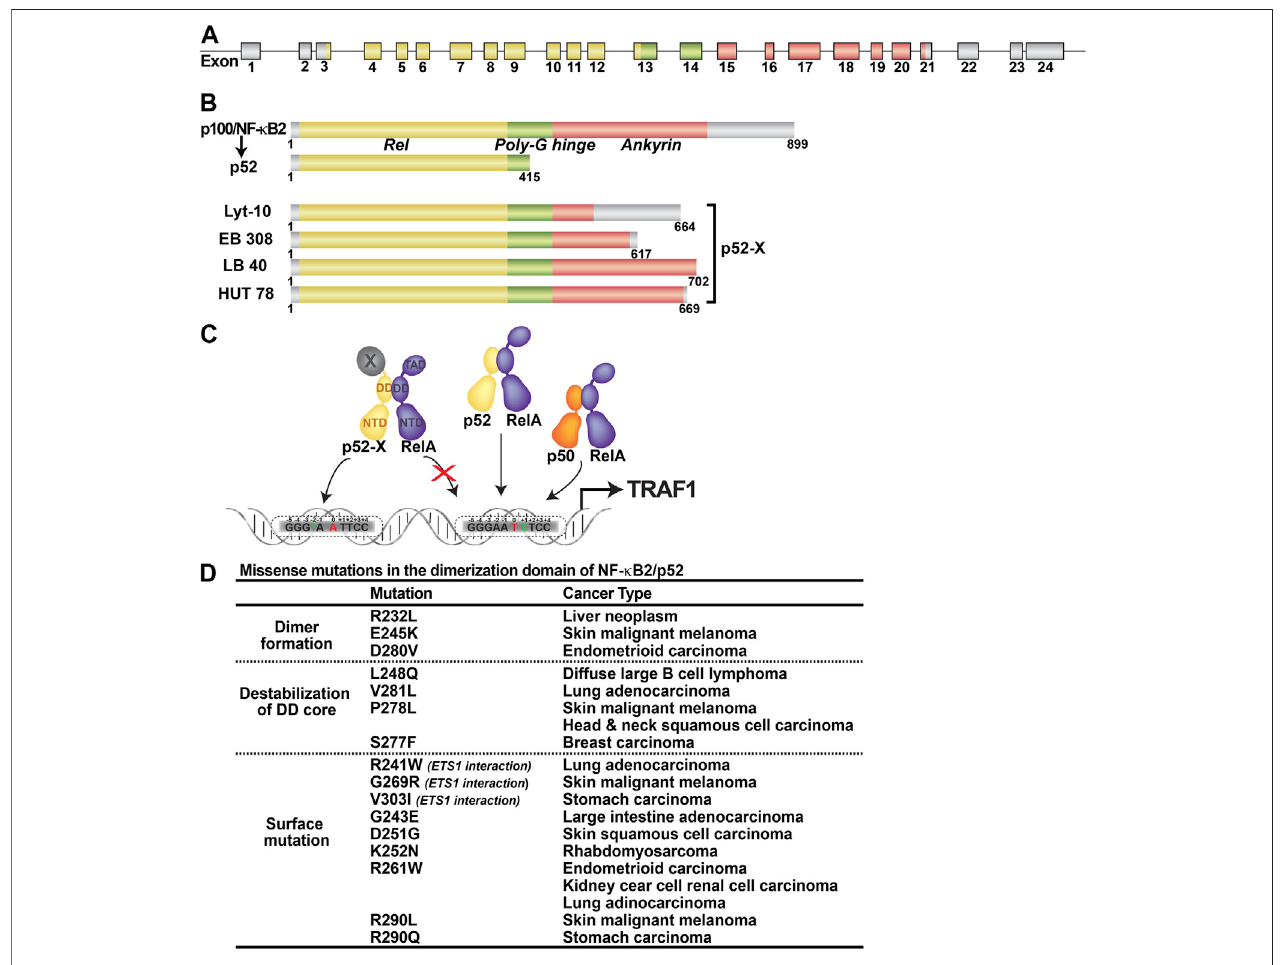
FIGURE5| Abnormalproductsof nf κ b2 gene. (A) The nf κ b2 geneisinvolvedinlymphoma-associatedchromosomaltranslocation. Codingexonsarerepresented by color fi lled boxes. (B) Truncated nf κ b2 genes code for C-terminal truncated protein variants lacking different portions of the ankyrin domain, named p52-X. (C) Oncogenic p52-X:RelA heterodimer preferentially binds to unfavorable κ B site. (D) Table showing the missense mutants in the dimerization domain of p52 and the corresponding caner types.